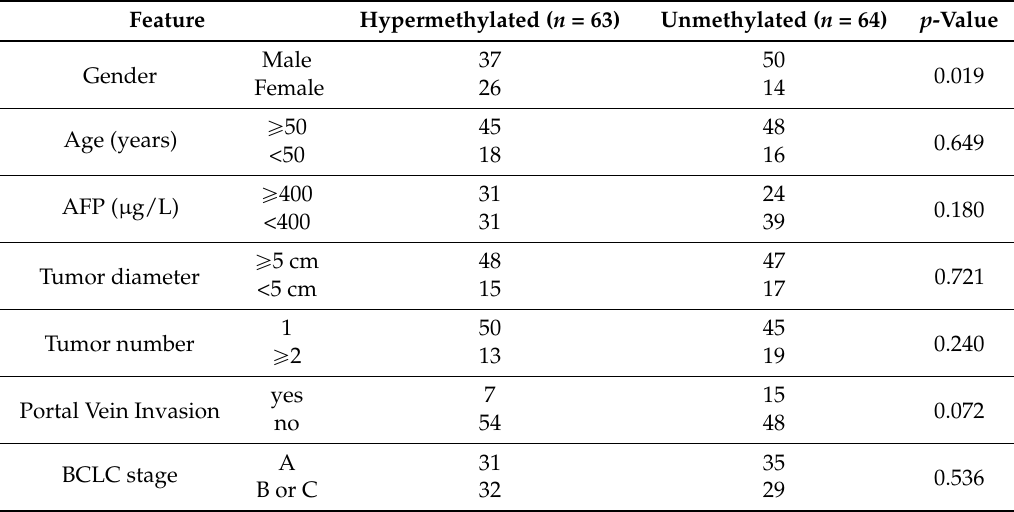
Table 1. Basonuclin 1 ( BNC1 ) CpG island (CGI) hypermethylation and clinicopathological correlations in hepatocellularcarcinoma